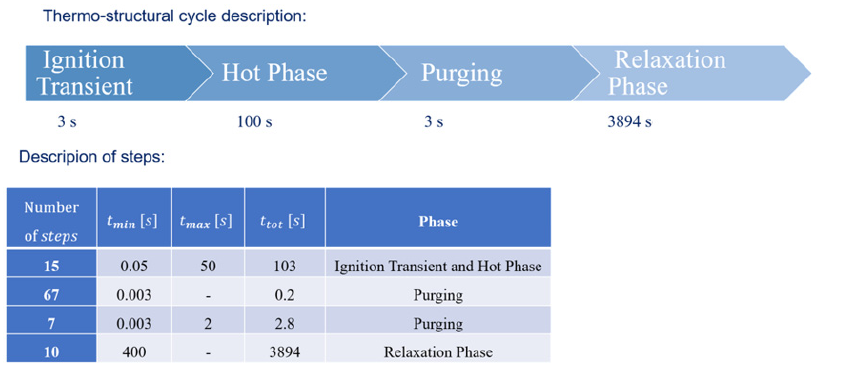
Figure 8. Thermo-structural cycle description [5].